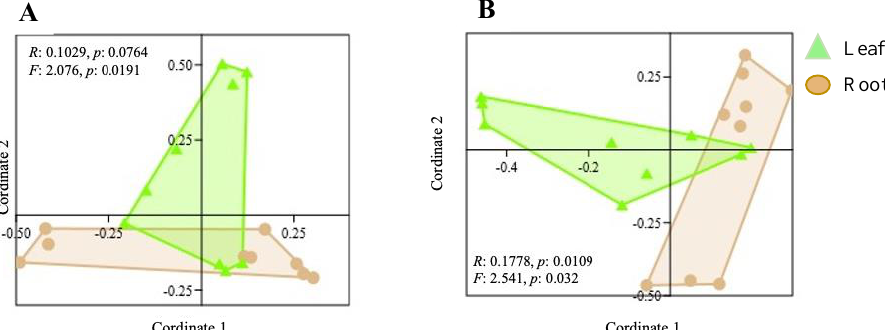
Figure 4. Fungal endophyte communities as influenced by growing conditions. Non ‐ metric multidimensional scaling (NMDS) plots for cluster analyses of the fungal endophyte community groups were calculated: ( A ) Bray–Curtis coefficient, which compares the presence or absence of fungal taxa along with the abundance among groups; ( B ) Jaccard’s index, which is used to show the presence and absence of data to compare the similarity among groups. The ANOSIM statistic R and PERMANOVA statistic F values and the corresponding p ‐ values indicate the significance of dissimilarities obtained via the permutation of group membership with 9999 replicates.